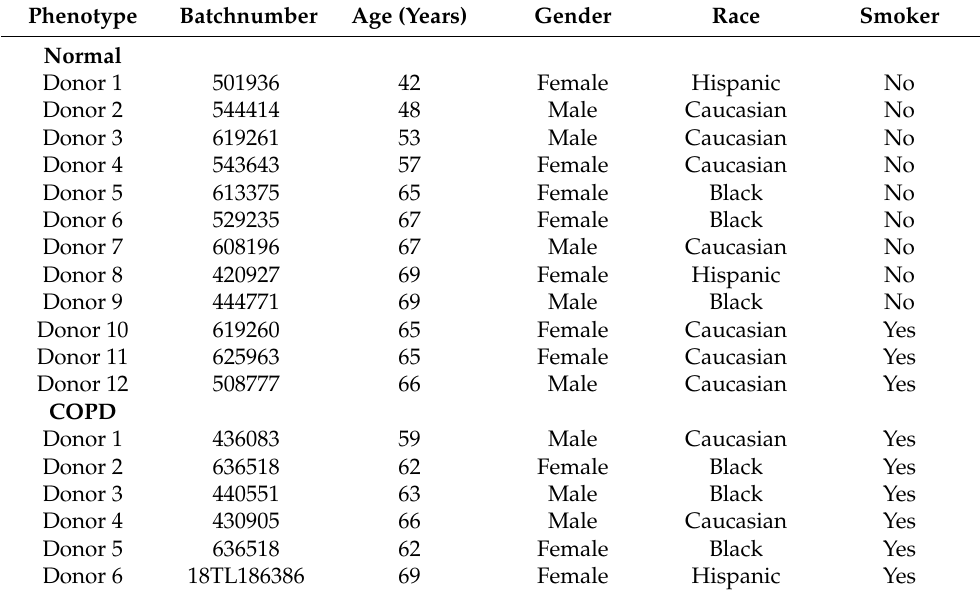
Table 1. Demographics of primary human bronchial epithelial cell (HBEC)